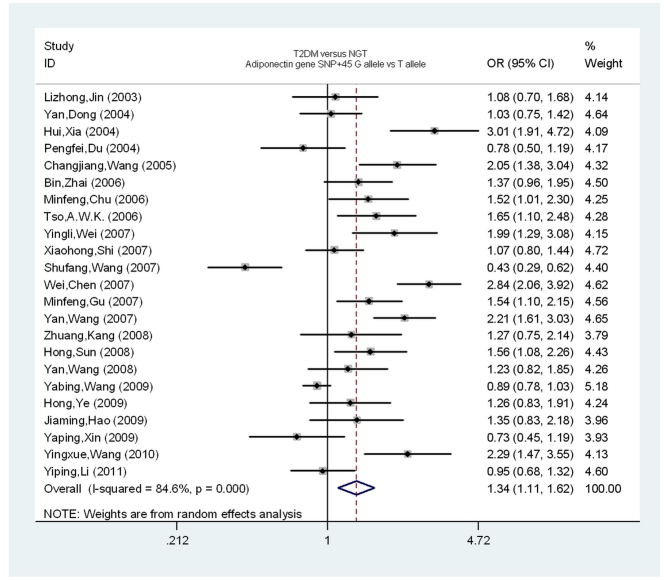
Individual and pooled ORs and 95% CI for SNP+45 (G vs.T) for all studies.